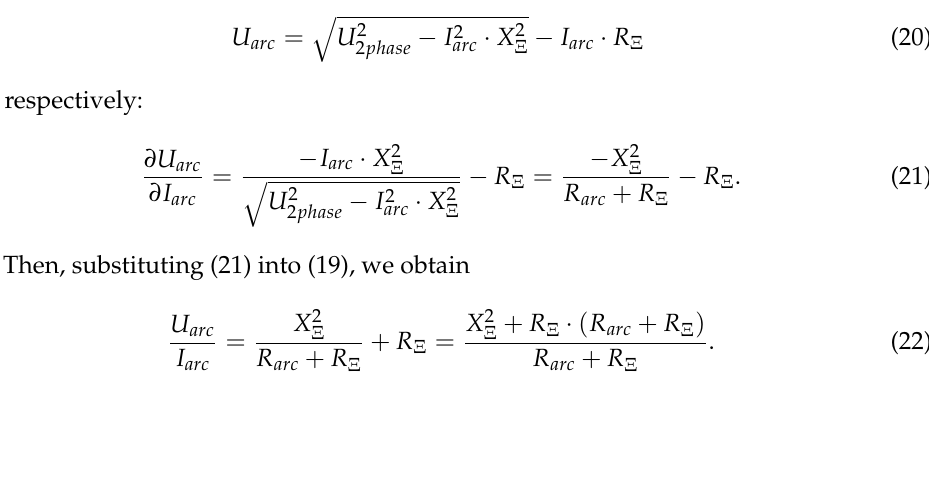
Figure 8. Choke current ( a ), mains voltage and current ( b ) based on the results of computer